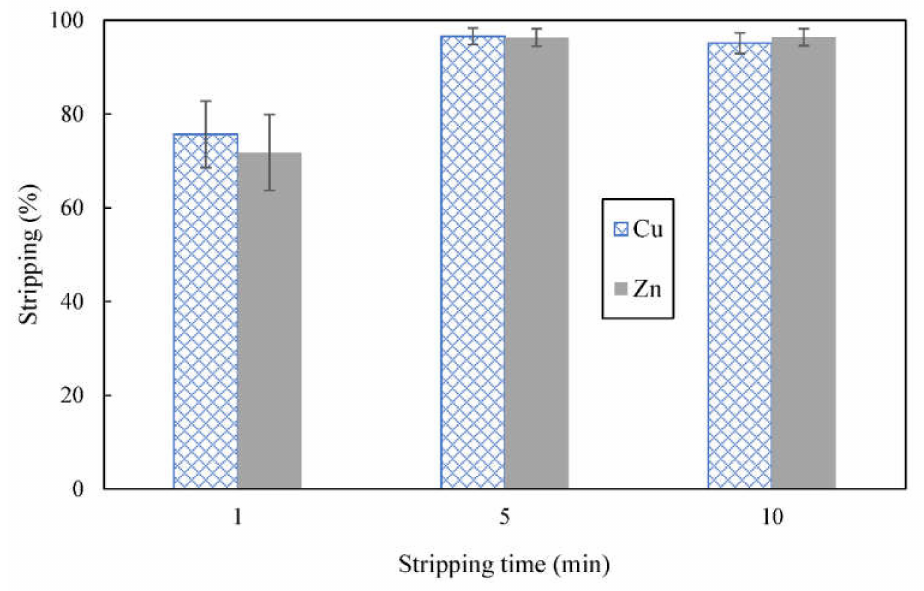
Figure 6. Effect of shaking time on stripping of metal ions from loaded organic phase; stripping solution consisted of 0.25 mol/L sulfuric acid, concentration of D2EHPA used was 4% ( v / v